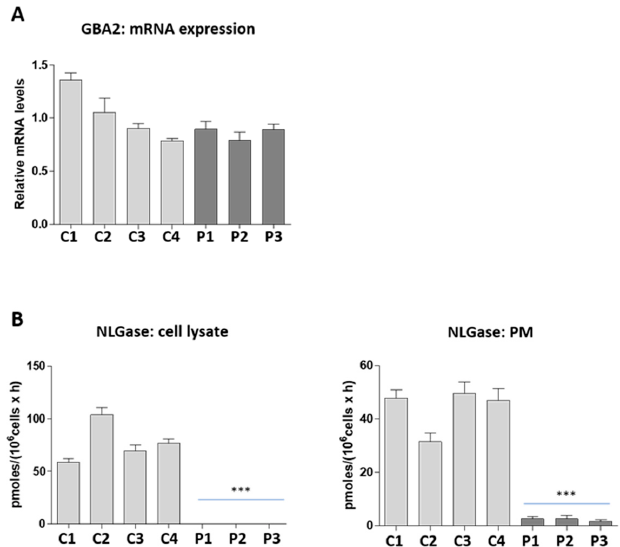
Figure 1. GBA2 mRNA expression and non-lysosomal glucosylceramidase (NLGase) activity. ( A ) The graph represents the GBA2 mRNA levels of controls (light grey) and patients (dark grey) relative to the average value of controls ( n = 4) after normalization with the endogenous β -actin gene ( ACTB ). Values represent the mean ± SEM of two independent triplicate experiments. ( B ) NLGase activity associated with the total cell lysates and plasma membrane (PM) of controls (light grey) and patients (dark grey) derived lymphoblastoid cell lines (LCLs). Enzymatic activity was expressed as pmoles/10 6 cells/h. Data are expressed as mean ± SD of three independent triplicate experiments (*** p < 0.0001 vs. controls).